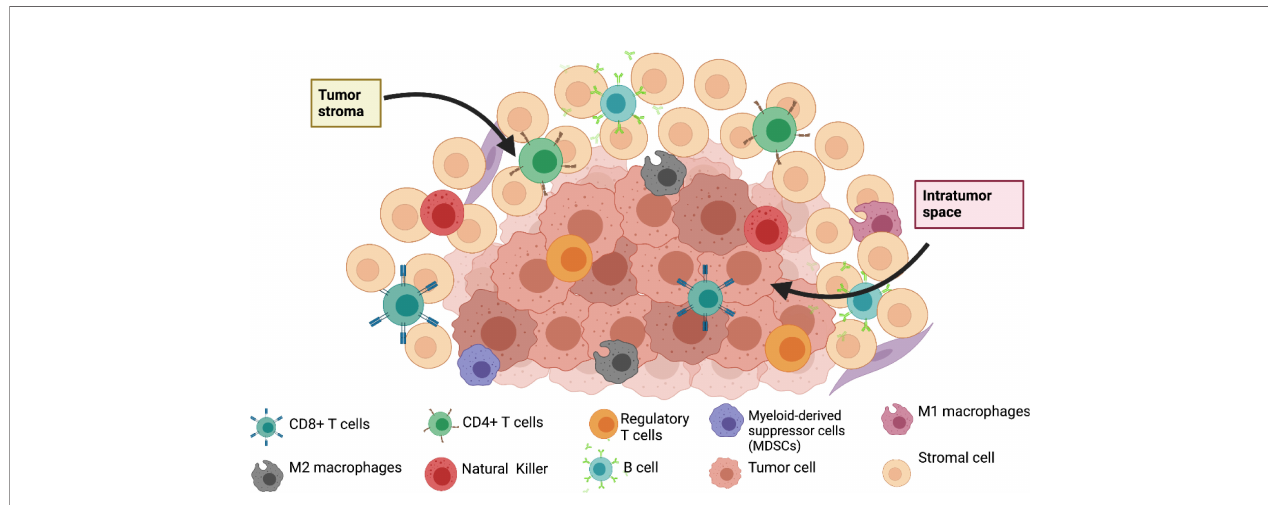
FIGURE 1 | Composition of tumor microenvironment in breast